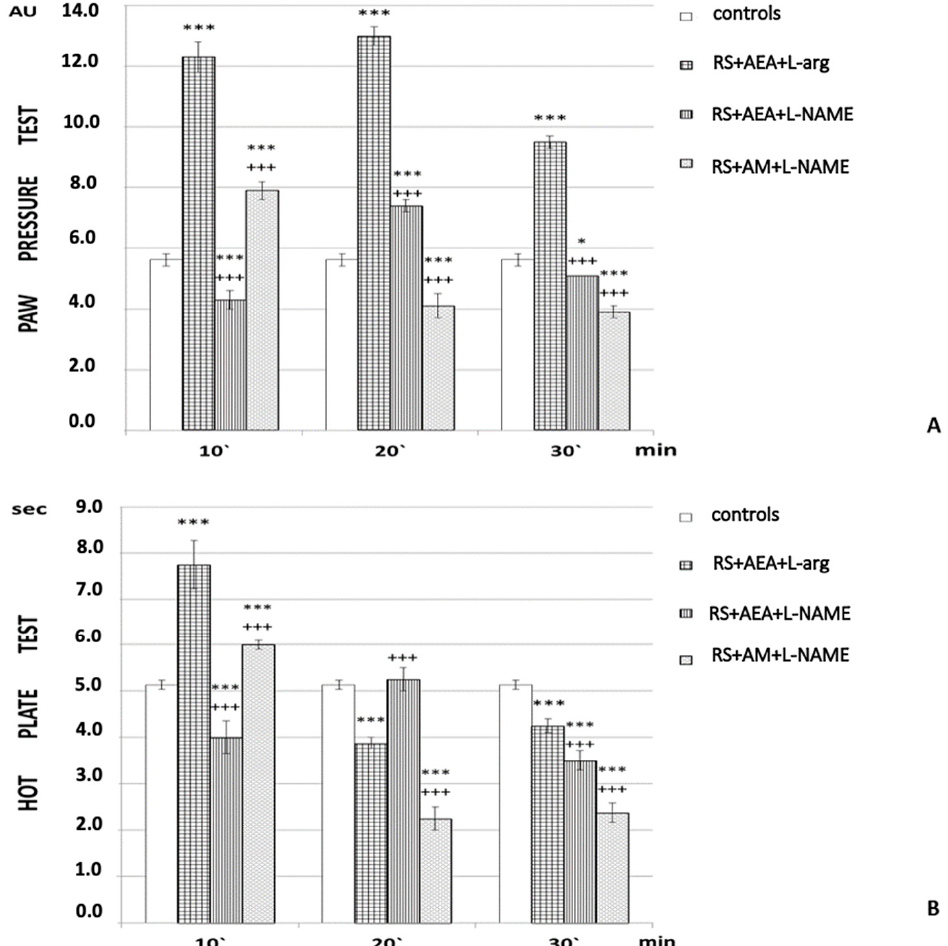
Figure 3. Effects of AEA and L-arg with L-NAME AM251 + L-NAME pretreatment estimated by ( A ) PP and ( B ) HP tests after 1 h of restraint (1 h RS) in rats. The mean values ± SEM are presented. *** p < 0.001, * p < 0.05 vs. control; +++ p < 0.001 vs. 1 h RS + AEA + L-arg; p < 0.001 (F = 1001.73346 at the 10th min; F = 232.52248 at the 20th min; F = 536.92814 at the 30th min).